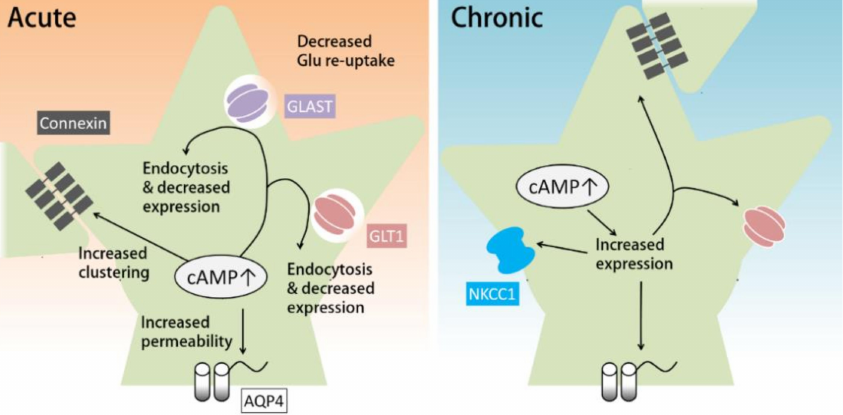
Figure 2. The role of cAMP in the maintenance of extracellular environment by astrocytes. ( Left ) Acute cAMP increase by cAMP analogues or adenylyl cyclase activators has been shown to decrease glutamate re-uptake through endocytosis of glutamate transporters. Astrocytic cAMP can also decrease the expression of glutamate transporters. In addition, short-term cAMP increase in astrocytes facilitates the clustering and also elevates water permeability of aquaporin 4 (AQP4). ( Right ) Long-term